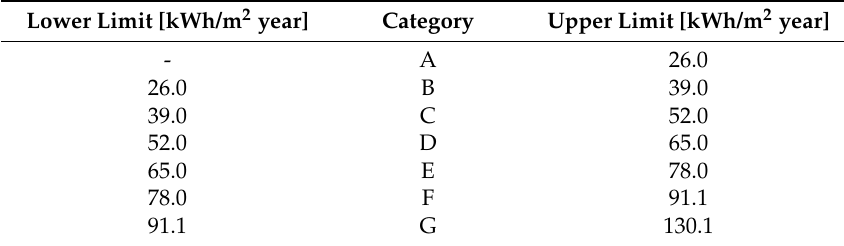
Table 8. Classification depending on Primary Energy Index levels.